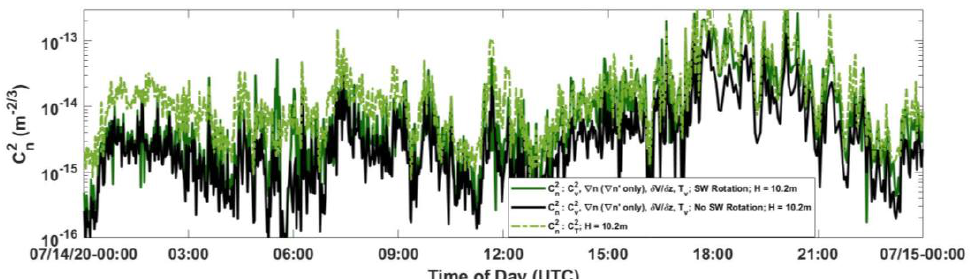
Figure 7. Profiles of C n2 at 10.2 m above the surface after applying streamwise (SW) triple rotation scheme about the sonic anemometer’s “u”, “v”, and “w” coordinate system.